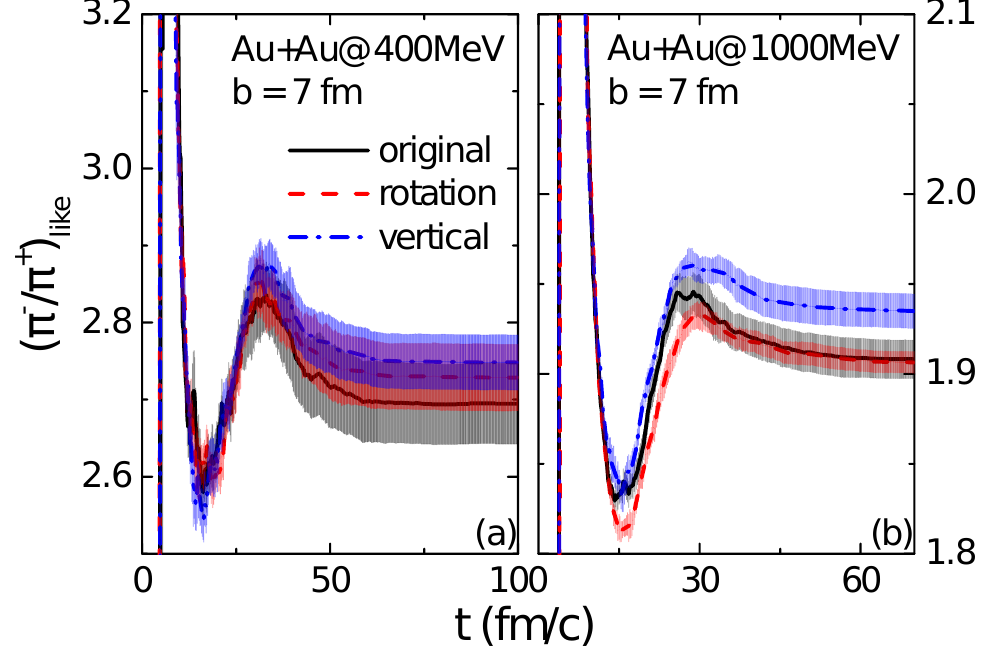
Figure 10. Time evolution of the ( π − / π + ) like ratio from three collision prescriptions in non-central Au+Au collisions at E lab = 400 ( a ) and 1000 ( b )